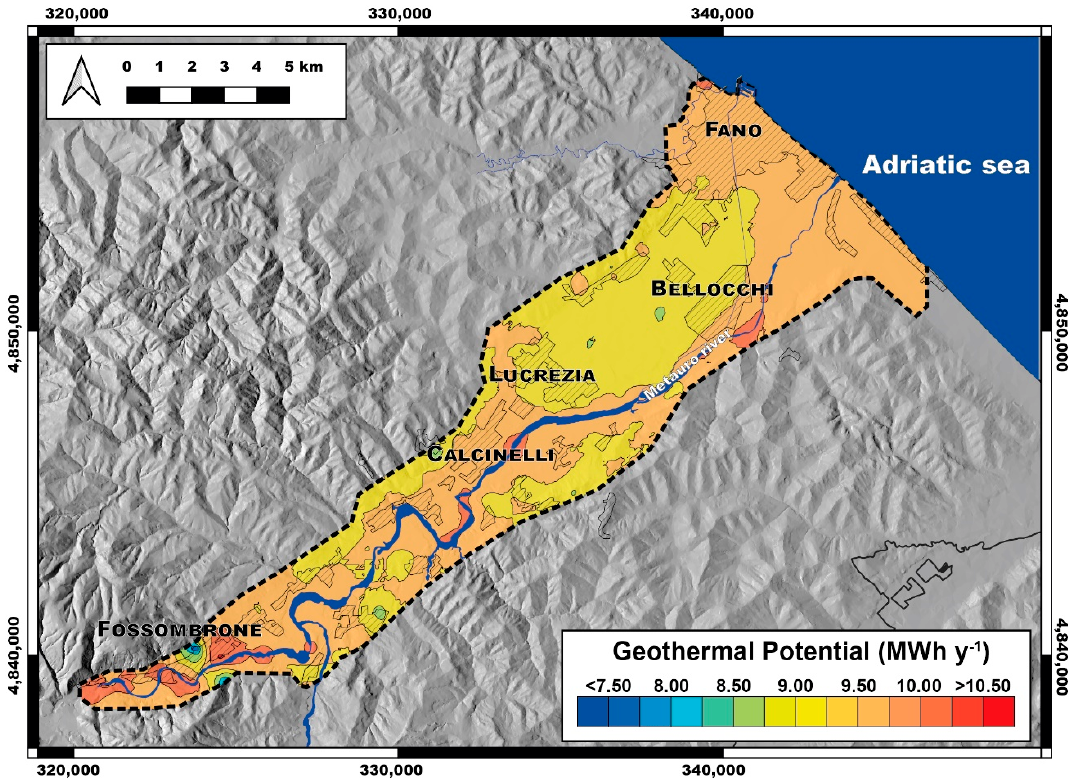
Figure 8. Map of the estimated geothermal potential for the study